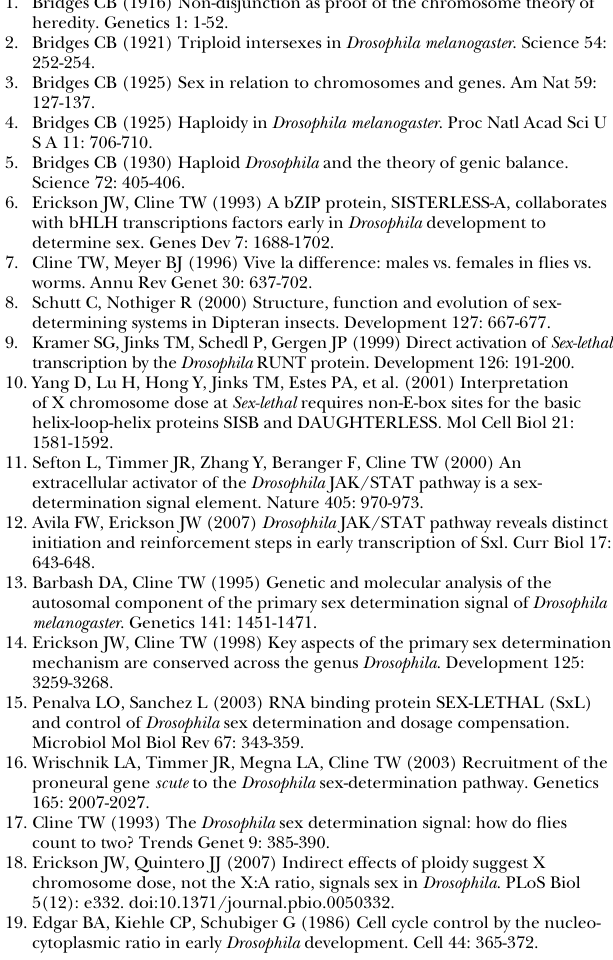
division cycle and occurs during nuclear cycle 15 [19].